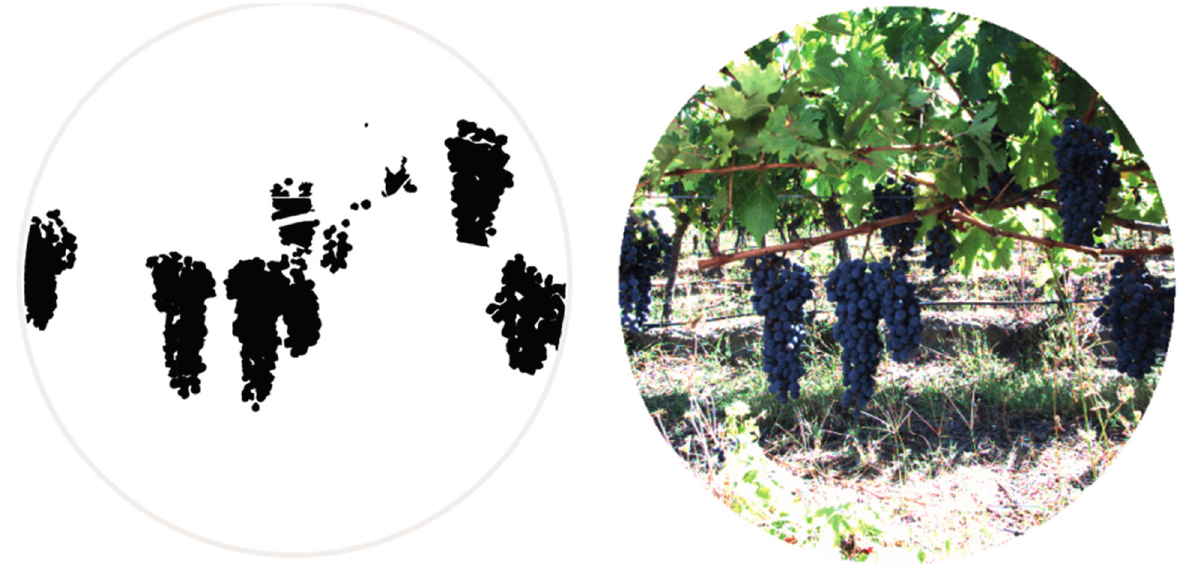
Figure 18. Pixel-based masking for grapes bunches.